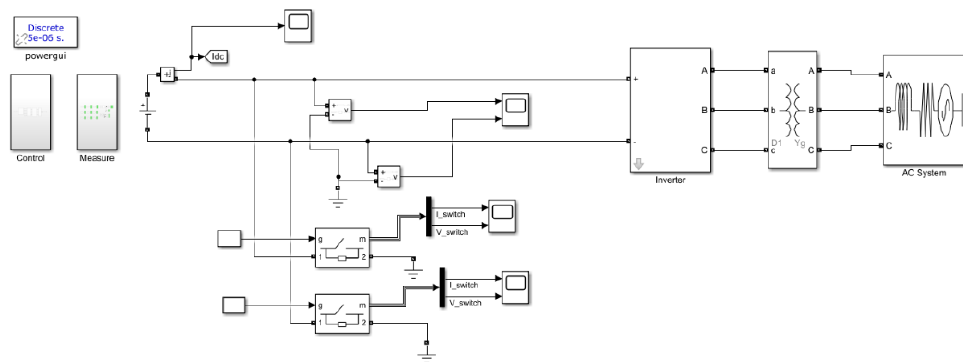
Figure A1. Simulation model of the MMC DC transmission system.